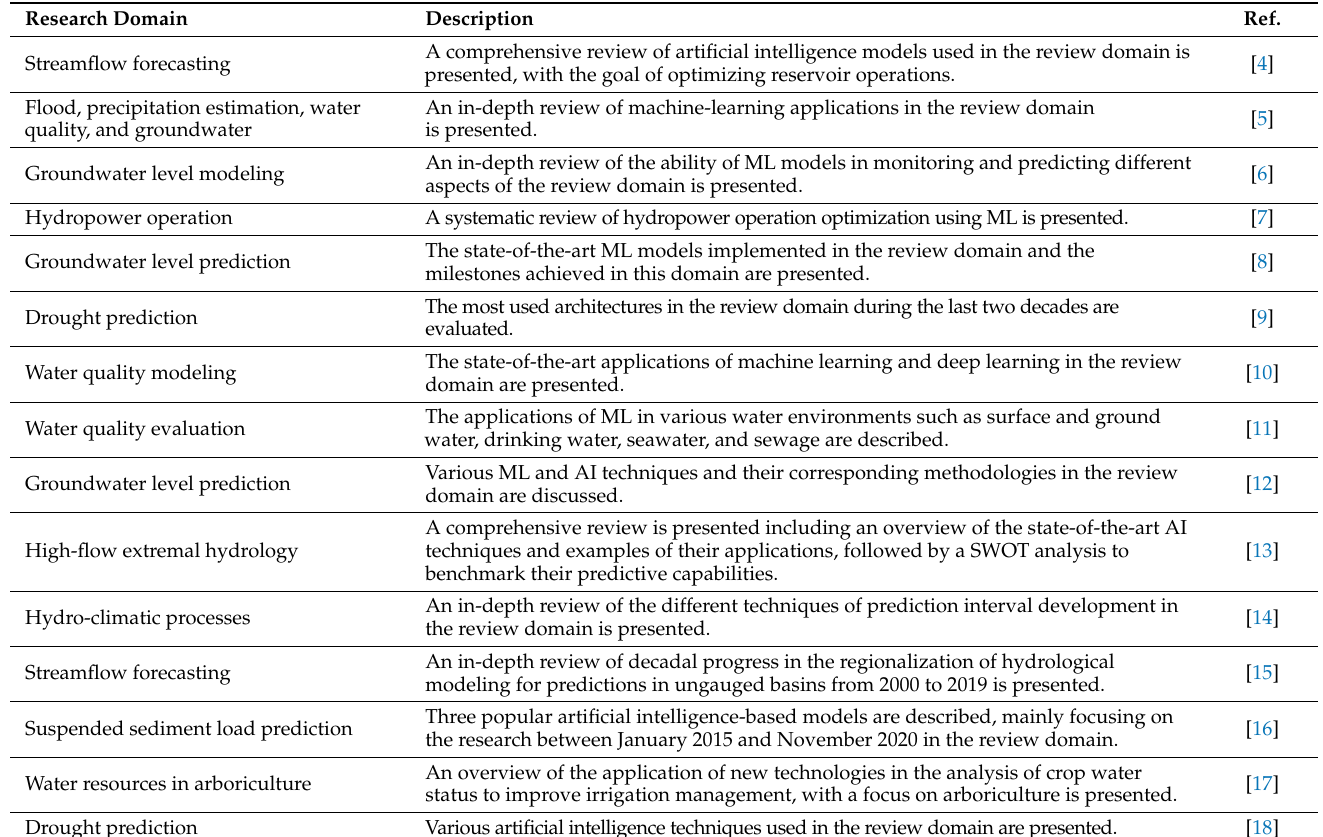
Table 1. Recent review articles on machine learning applications in